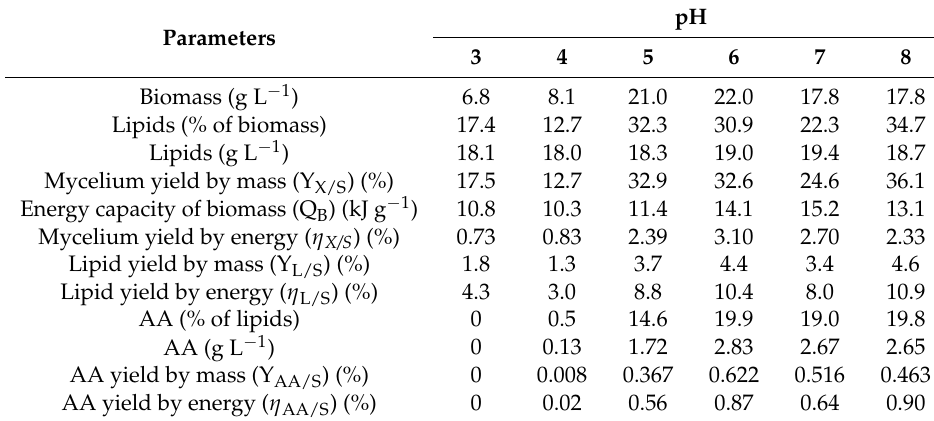
Table 2. The effect of pH on the yields of biomass, lipids, and arachidonic acid in M. alpina NRRL-A- 10995 in the stationary